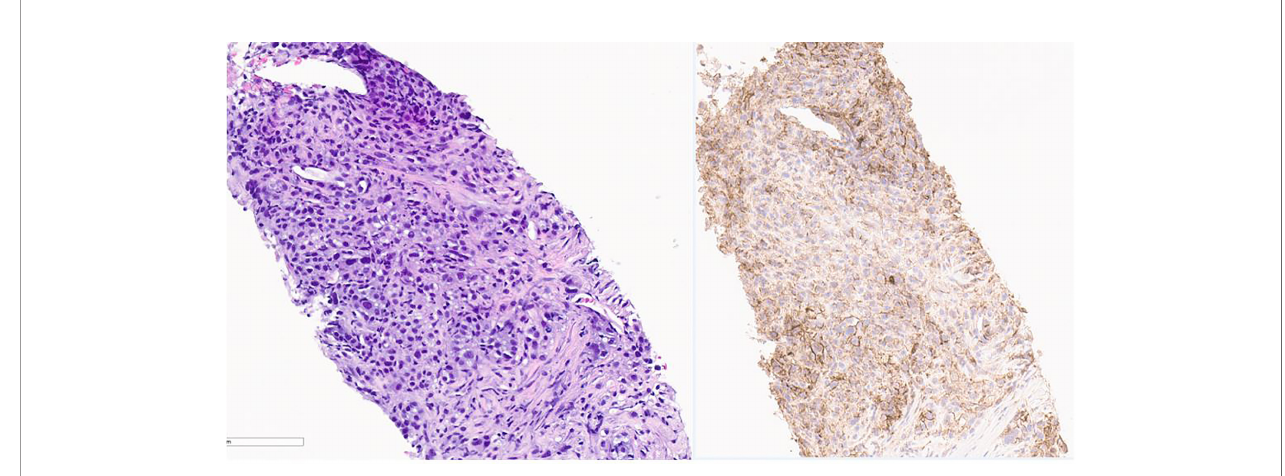
FIGURE 3 | Pathology image of lung nodule biopsy showing PD-L-1 positivity. On the left is Hematoxylin & Eosin stain and on the right is PD L-1 immunohistochemistry stain showing PD-L-1 positivity. Pictures taken at